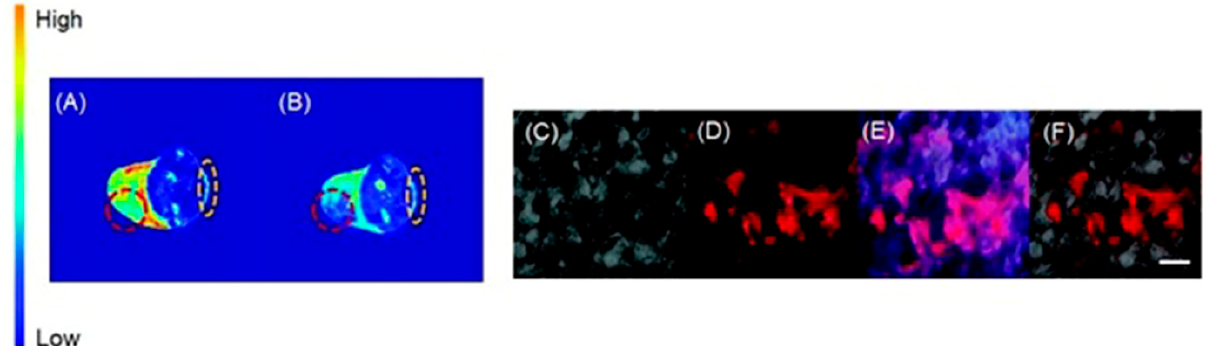
Figure 22. T 2 -weighted MRI images of subcutaneous tumor-bearing mouse ( A ) before, and ( B ) after injection of the nanoprobe. The tumor is highlighted in red dashed circle and normal tissues are highlighted in yellow dashed circle. A contrast enhancement (darkening) on the tumor site due to elevated levels of glutathione compared to normal tissues was observed. Time-gated luminescence images of the cryosection tumor from the tumor-bearing mouse injected with the nanoprobe. ( C ) bright field image, ( D ) time-gated luminescence image, ( E ) steady-state luminescence image, ( F ) merged image of ( C , D ). Scale bar: 10 μ m. An intense red intracellular luminescence was observed in the cytoplasm of the cells, indicating that the nanoprobe was internalized into cells, and MnO 2 nanosheets were reduced to Mn II by intracellular glutathione, triggering luminescence recovery of the Eu III -containing complex. Adapted with permission of the Royal Society of Chemistry, from A dual-modal nanoprobe based on Eu(III) complex-MnO 2 nanosheet nanocomposites for time-gated luminescence-magnetic resonance imaging of glutathione in vitro and in vivo, Song, B.; Shi, W.; Shi, W.; Qin, X.; Ma, H.; Tan, M.; Zhang, W.; Guo, L.; Yuan J. 11 , 14, 2019 ; permission conveyed through Copyright Clearance Center, Inc. [302].